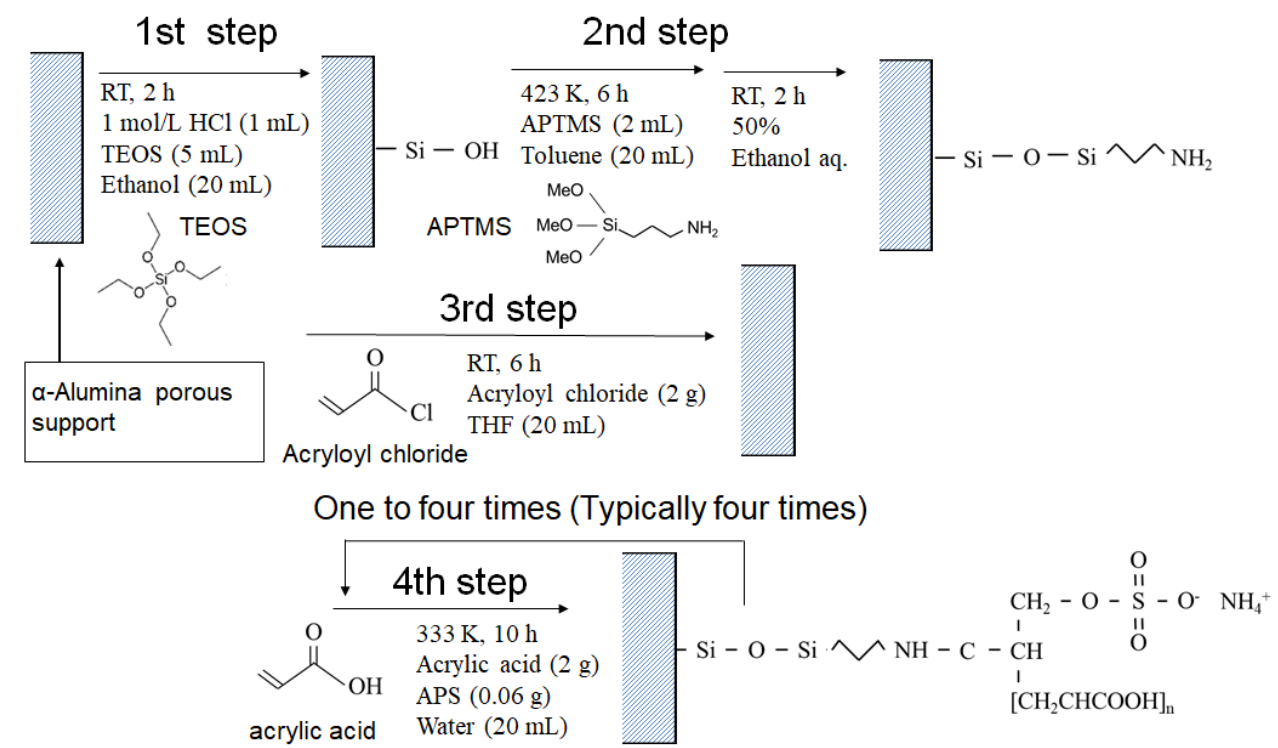
Figure 1. Synthetic route for the PAA-coated porous membrane.